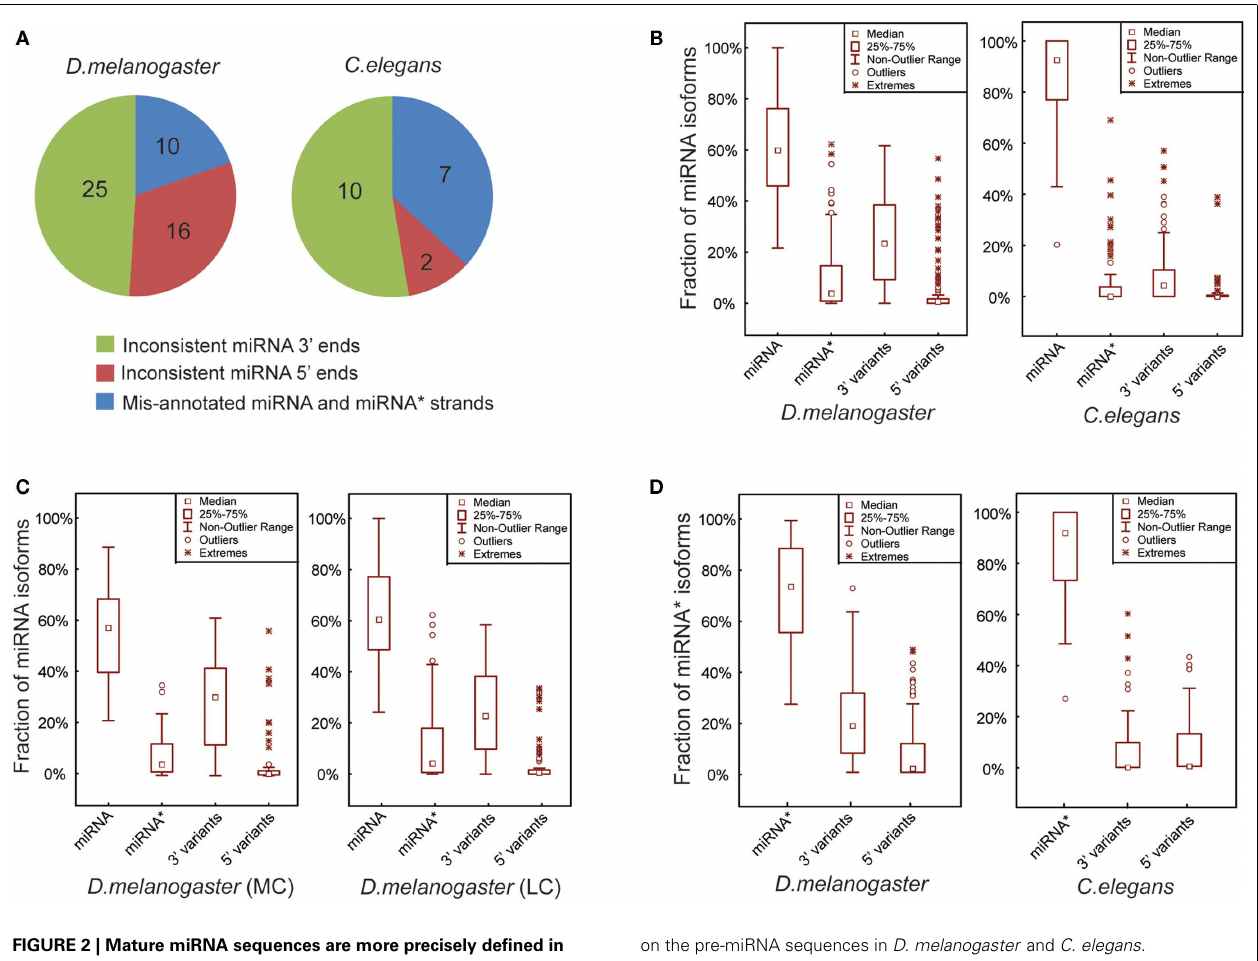
on the pre-miRNA sequences in D. melanogaster and C. elegans. (C) Percentages of miRNA, miRNA ∗ , miRNA 3 (cid:2) and 5 (cid:2) variant reads in D. melanogaster MC and LC miRNAs. (D) Percentages of exact miRNA ∗ reads, miRNA ∗ 3 (cid:2) and 5 (cid:2) variant reads in D. melanogaster